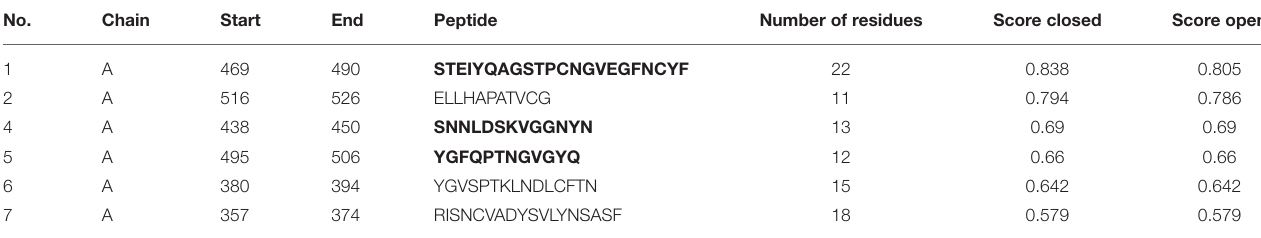
TABLE 5 | Conformational predictive scores between the open and closed conformation of the RBD of spike protein of SARS-CoV-2. No. Peptide Number of residues Score closed Score